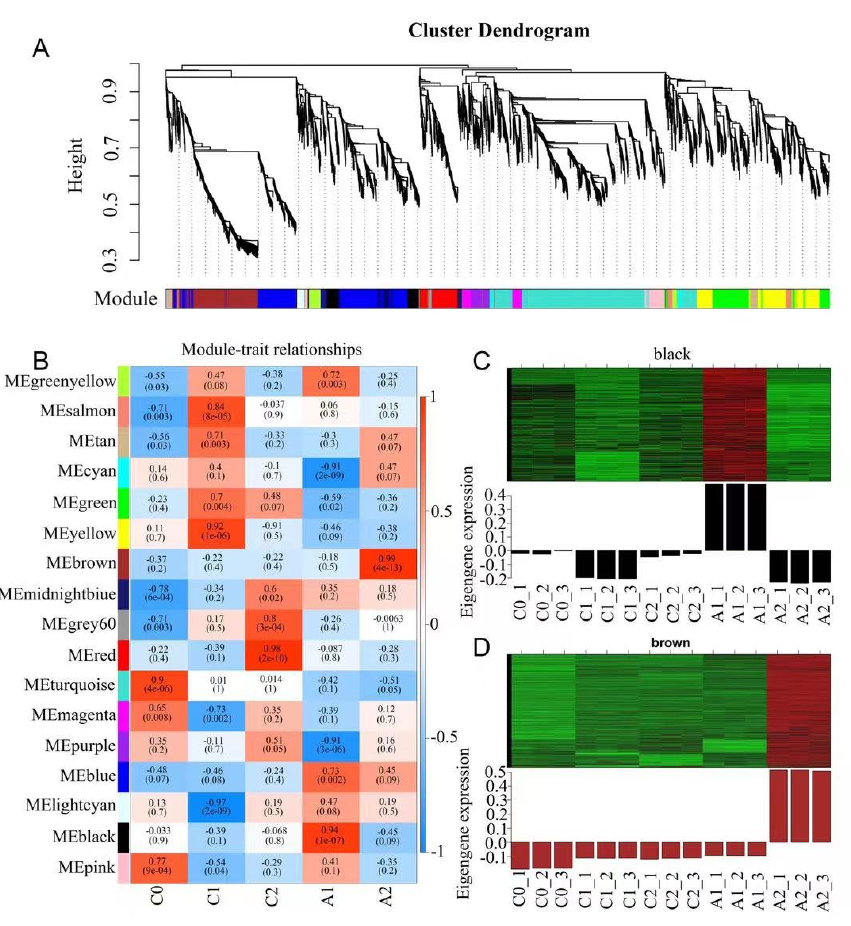
Figure 3. Weighted gene co-expression network analysis (WGCNA) of DEGs identified. ( A ) Gene cluster dendrogram tree showing 17 modules of co-expressed genes. Each of the 6641 DEGs is represented by a tree leaf and each of the modules by a major tree branch. The color row underneath the dendrogram shows the module assignment determined by the Dynamic Tree Cut. ( B ) Module−trait relationships. Each row corresponds to a module, and each column corresponds to a time point. The number of each cell at the row−column intersection indicates the module−trait correlations and corresponding p−values (in parentheses) between the module and the time points. The left panel shows the 17 modules. The right panel shows the color scale of module−trait correlations from blue to red (−1 to 1). ( C ) Gene expression of the black module. ( D ) Gene expression of the brown module.